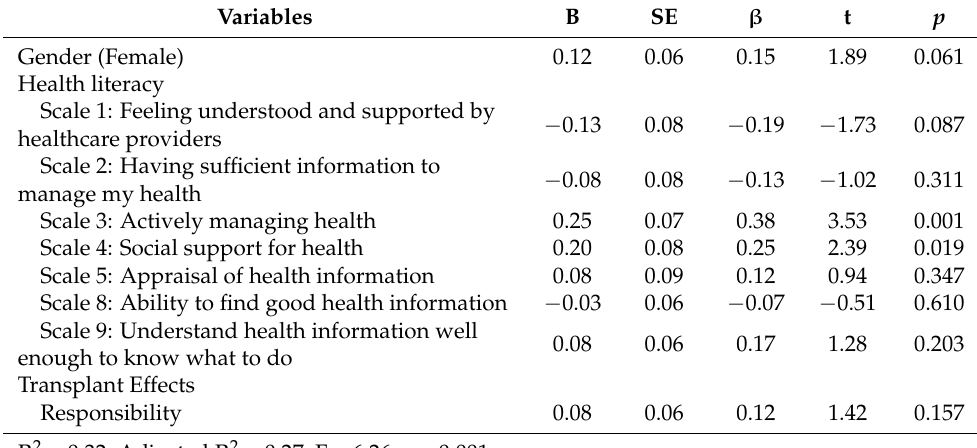
Table 5. Factors associated with compliance to treatment ( n =